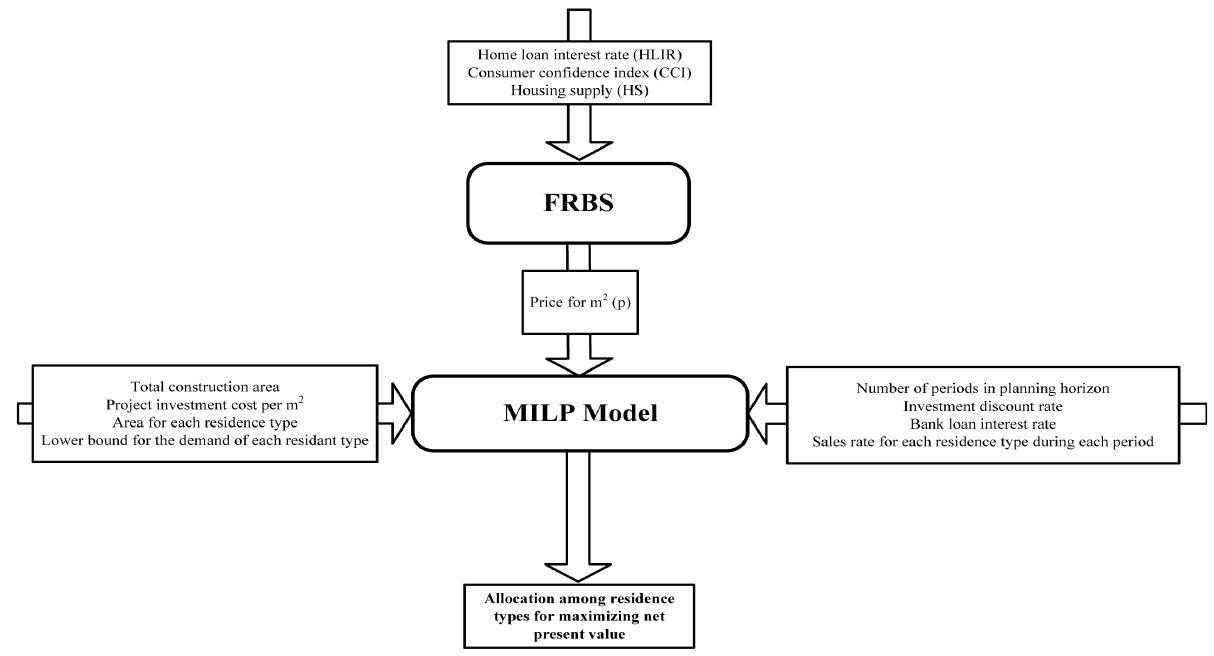
Fig. 1. Framework of the proposed